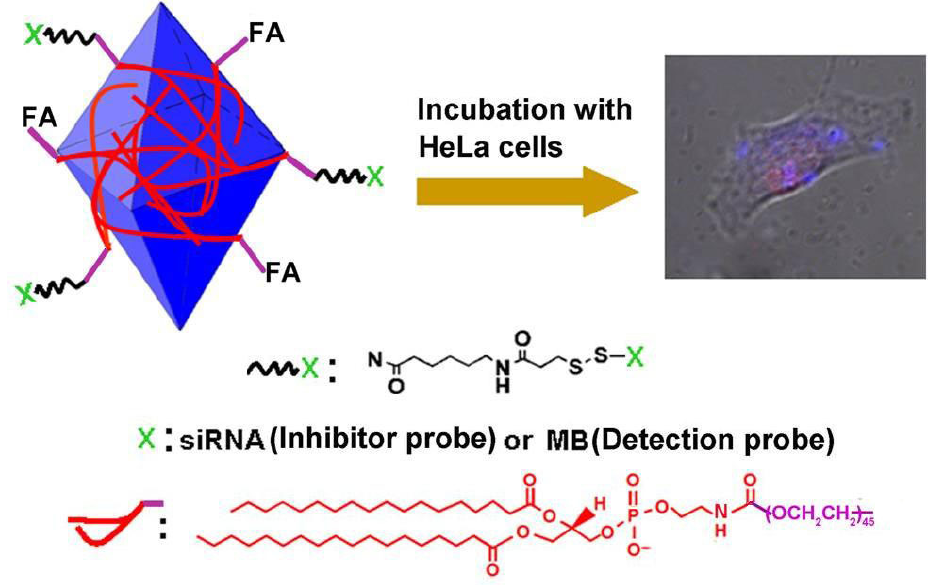
Figure 13. Schematic representation of mf-SnO2 nanoprobe for target-specific-cell imaging and intracellular detection of miRNA. FA = folic acid, MB = molecular beacon. Reprinted with permission from [73]. Copyright 2012 John Wiley and Sons.